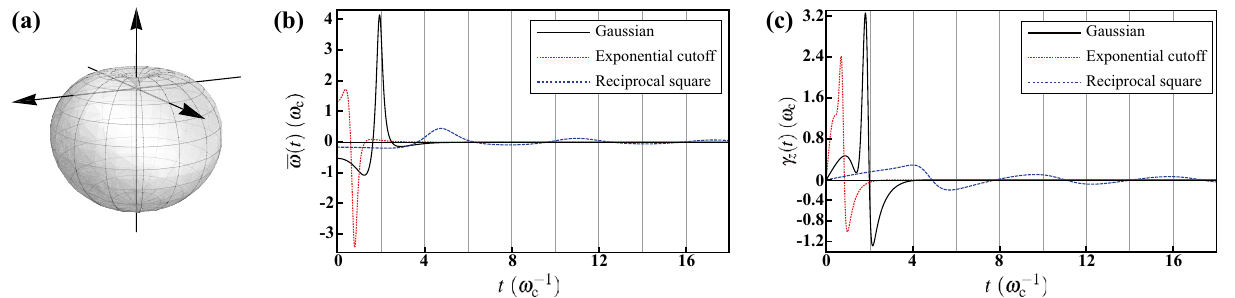
Figure 6. Decoherence under the HE with the geometry of 3D cardioid. ( a ) Visualization of the solid angular ( 1 cos θ)/ 4 π of the probability distribution. This geometry exhibits the azimuthal symmetry part �(θ , φ) = − exclusively; meanwhile, this leads to the balanced regime square (blue dashed cruve) radial functions. Its presence is a result of the lack of the reflectional symmetry about the x - y plane. ( c ) The decay rate γ z ( t ) for the Gaussian (black solid curve), the exponential cutoff (red dotted curve), and the reciprocal square (blue dashed cruve) radial functions. The line shape is similar to the one under spherical symmetry appended by an additional drop before the peaking value, which is a result of the